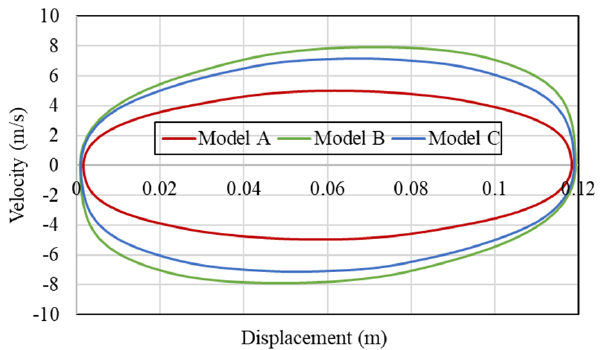
Figure 16. Comparison of the velocity of three models versus piston displacements. The air is compressed in the compressor part and the pressure increases with the decrease of the volume of the compressor, which can be seen in Figure 17. Model ‘B’ has the highest pressure (9.78 bar) when the volume reduces to the position near TDC and BDC, while model ‘A’ has the lowest peak pressure (7.49 bar). The pressure amplitude in Model ‘B’ is the largest among the models. The three cases (i.e., Model ‘A’–‘C’) apply roughly the same valve timings, therefore the velocity profiles, and, in turn, the frequencies of the systems, play a key role in pressure build-up. With the heaviest moving mass,